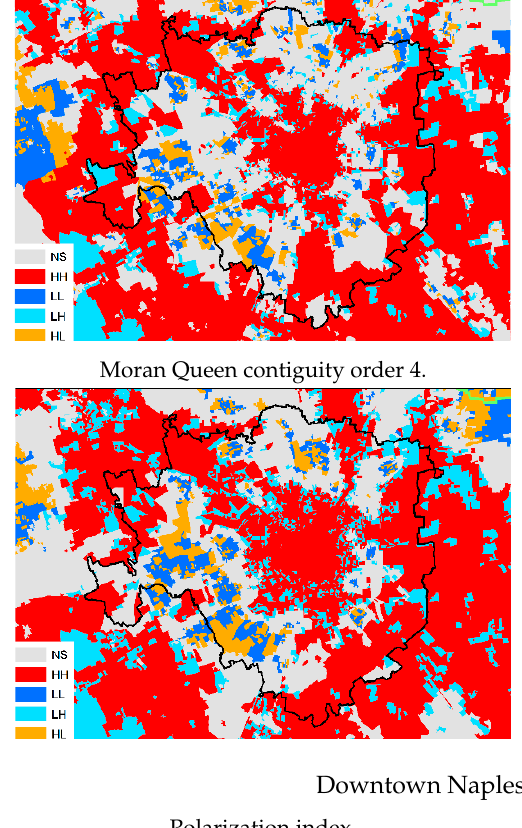
Moran Queen contiguity order 1.